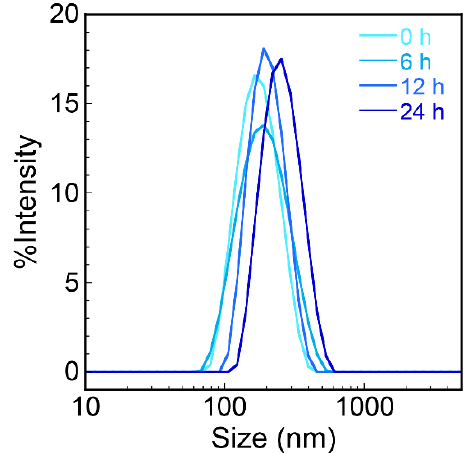
Figure 4. Time-dependent dynamic light scattering (DLS) measurements of the biocomposite nanoparticles composed of PPO and PPO-binding peptides.